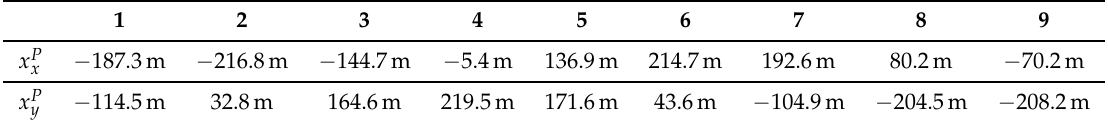
Table 2. Predefined points of